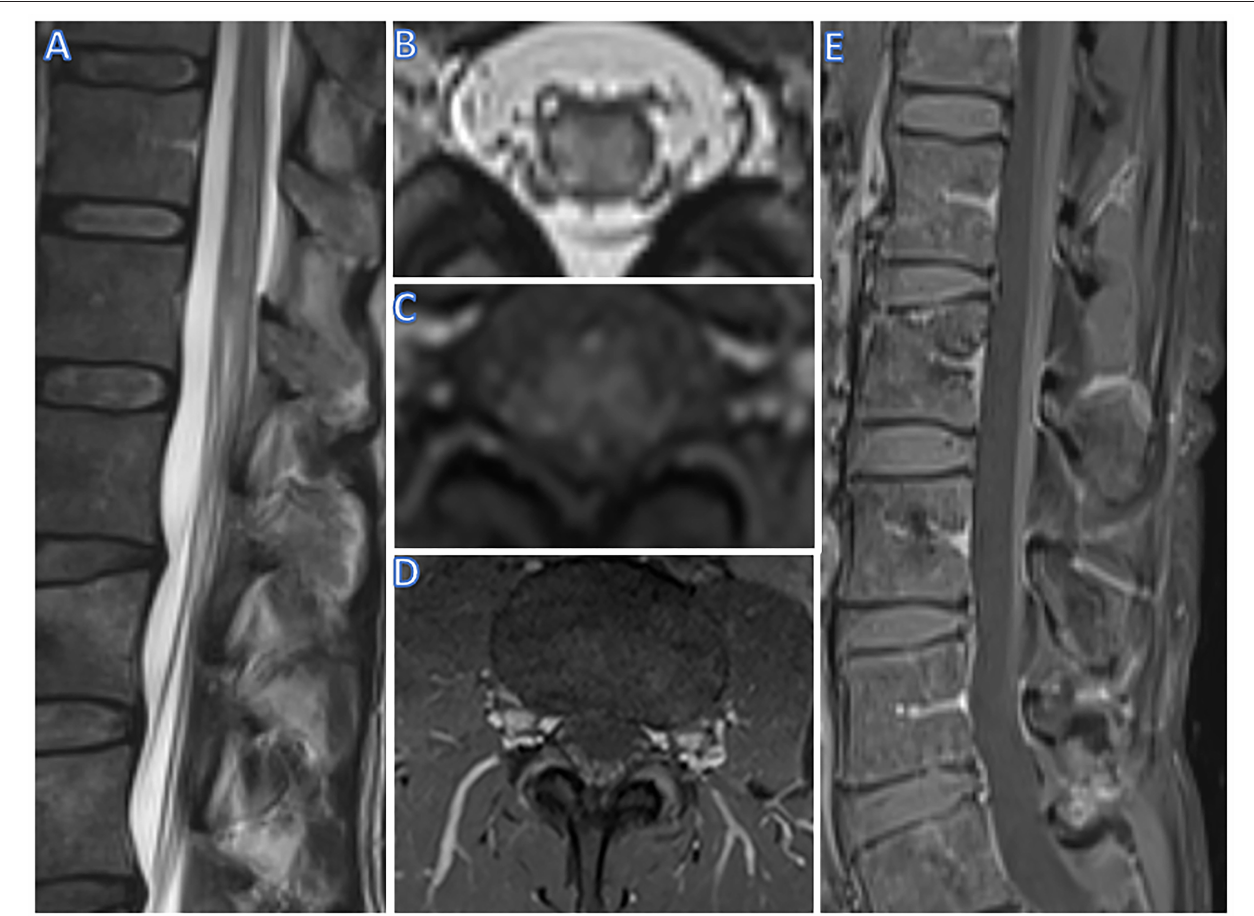
FIGURE 1 | R imaging of case 1 (male, 56 yrs). T2w hyperintense lesions and swelling of the conus (A) and selective hyperintensity and swelling of the gray matter on axial imaging (B) . On T1w, a diffuse contrast enhancement of the gray matter can be seen (C) , as well as contrast enhancement of spinal roots in axial (D) and sagittal imaging (E)